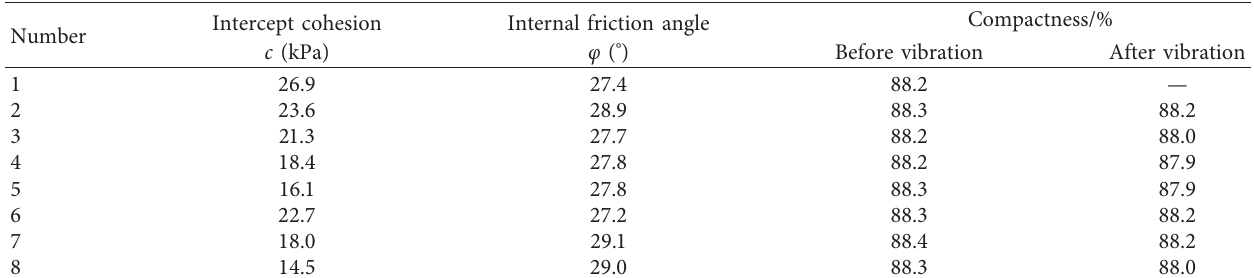
Figure 9: Macroscopic shear failure type of the soil samples. Table 5: Soil parameters under different working